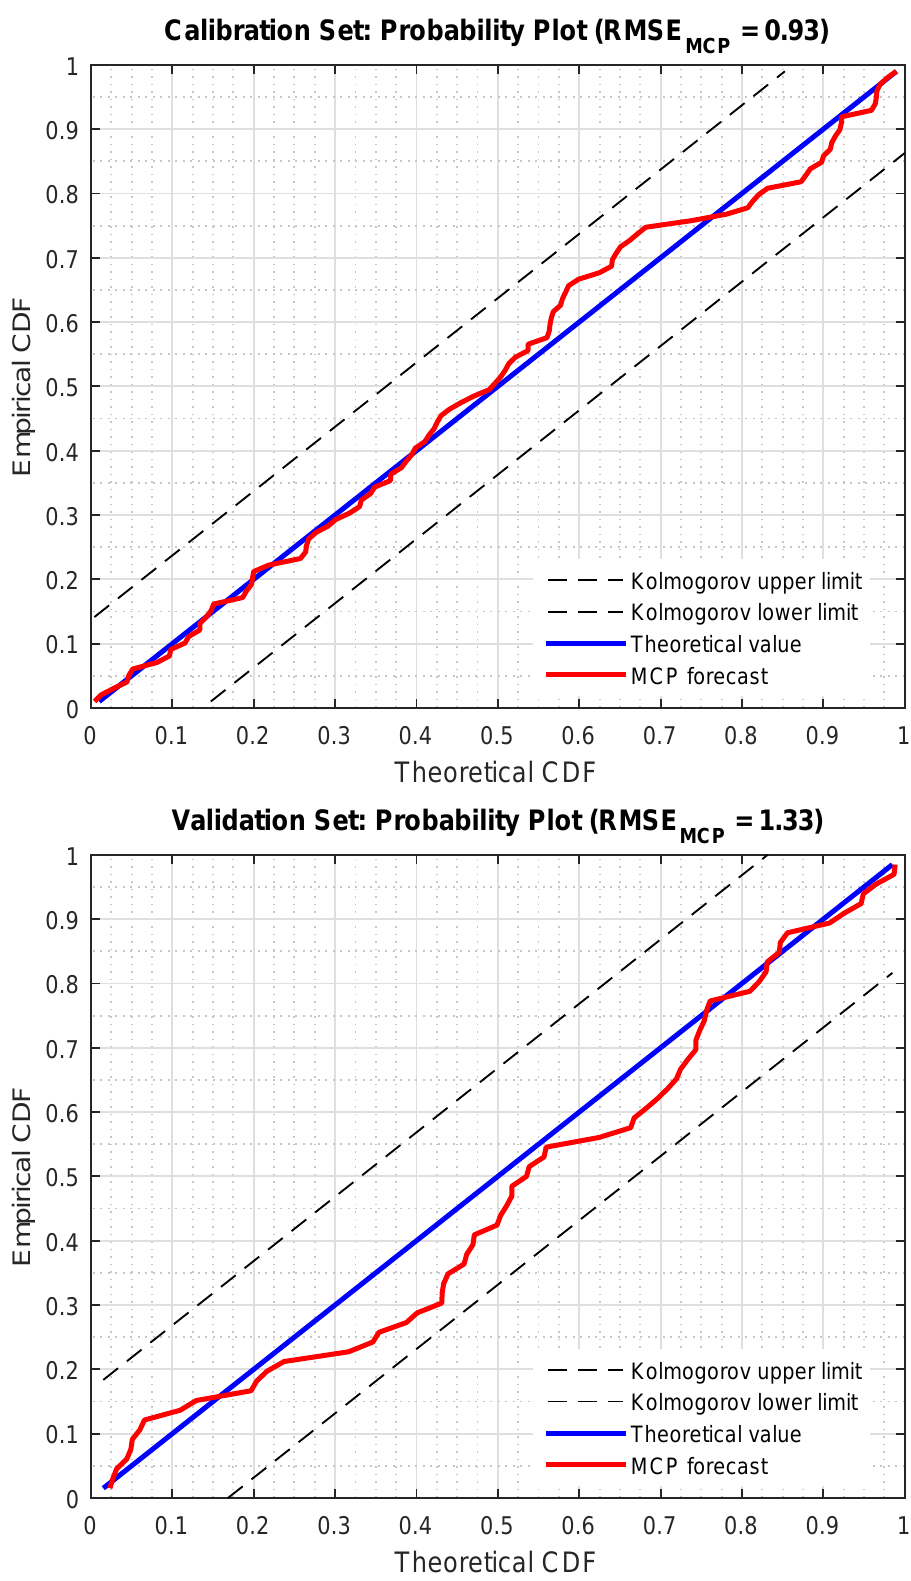
Figure 5. Calibration and Validation sets: 5% probability acceptance limits for MCP